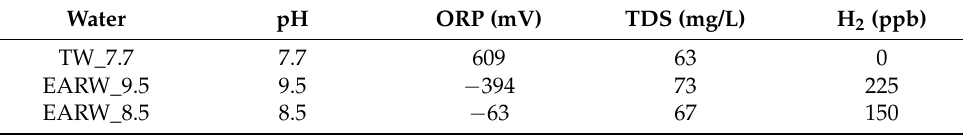
Table 1. Characteristics of the experimental